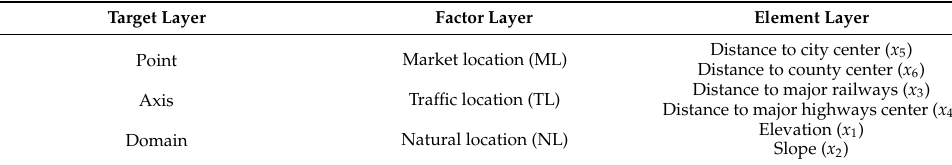
Figure 2. Three-dimensional location data processing process. Table 1. Point–axis–domain three-dimensional location